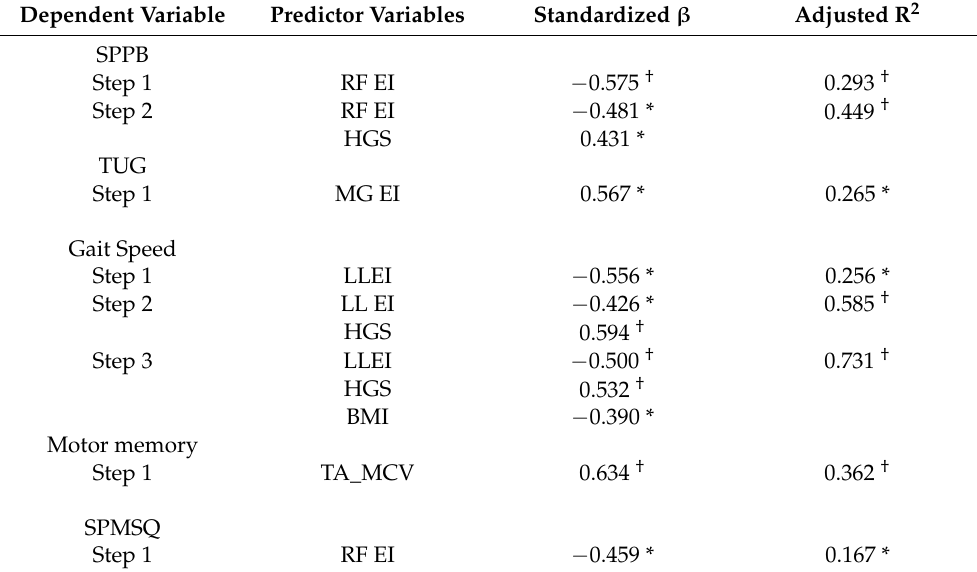
Table 3. Stepwise multiple regression analysis ( n =